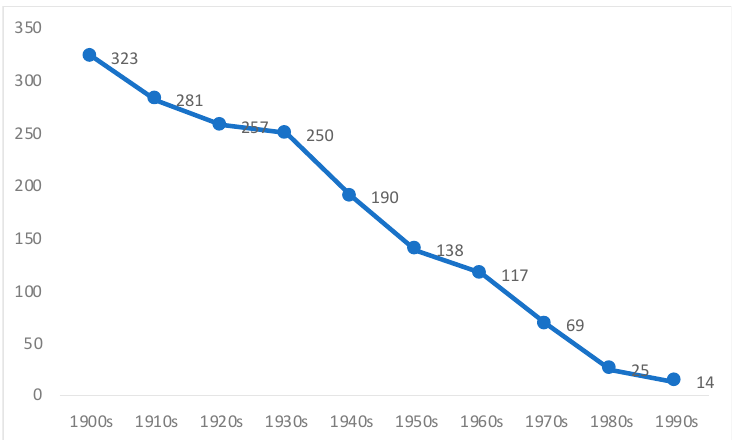
Figure 3. Infant mortality rates in Chile (boys only), 1900s–1990s (number of infant deaths for every 1000 live births). Source: Own elaboration from Llorca ‐ Jaña et al. [25].